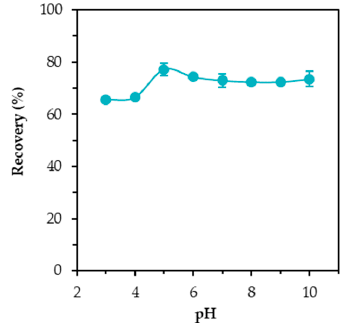
Figure 3. E ff ect of initial pH in sample solution on Cd recovery. Experimental conditions: Cd 10 µ g · L − 1 ;